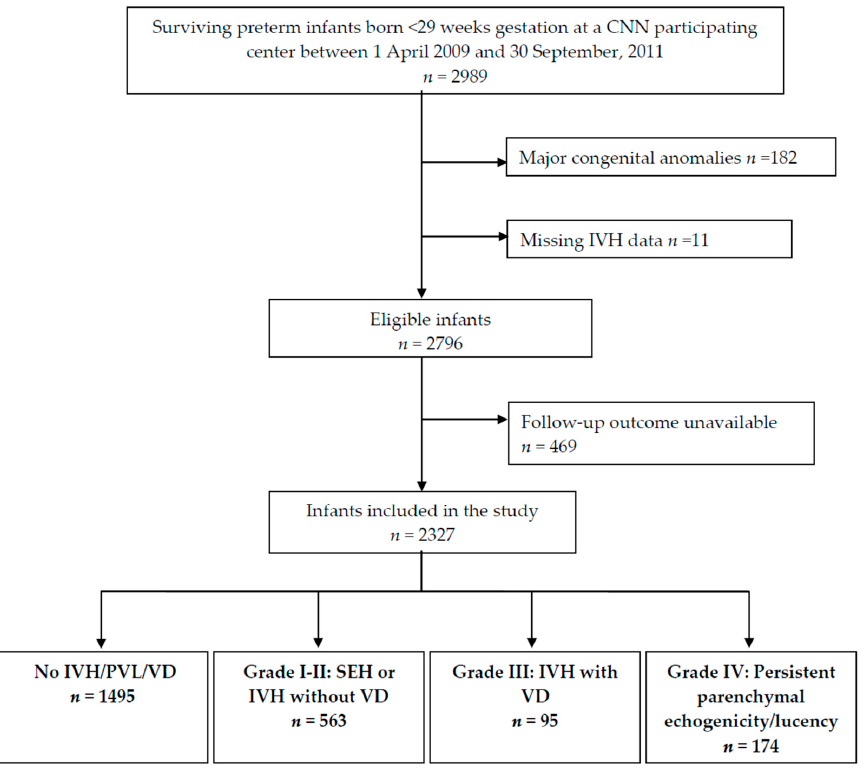
Figure 1. Flow diagram of the study population *. * CNN—Canadian Neonatal Network; IVH— intraventricular hemorrhage; PVL—periventricular leukomalacia; SHE—subependymal hemorrhage; VD—ventricular dilation.